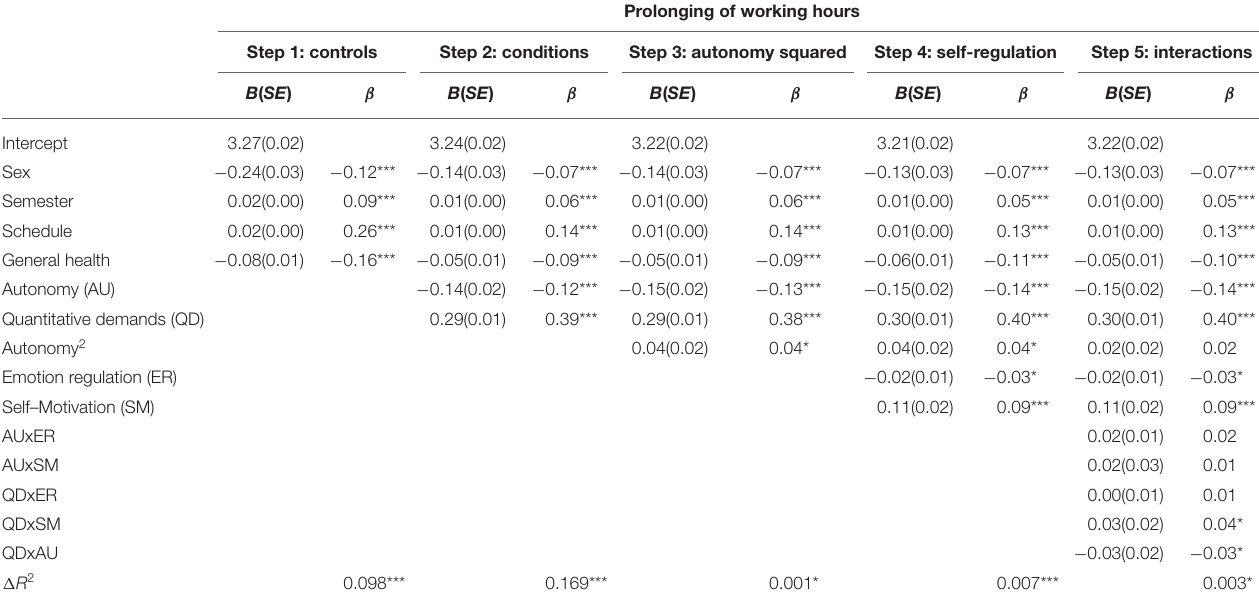
TABLE 2 | Stepwise regression analyses for the dependent variable prolonging working